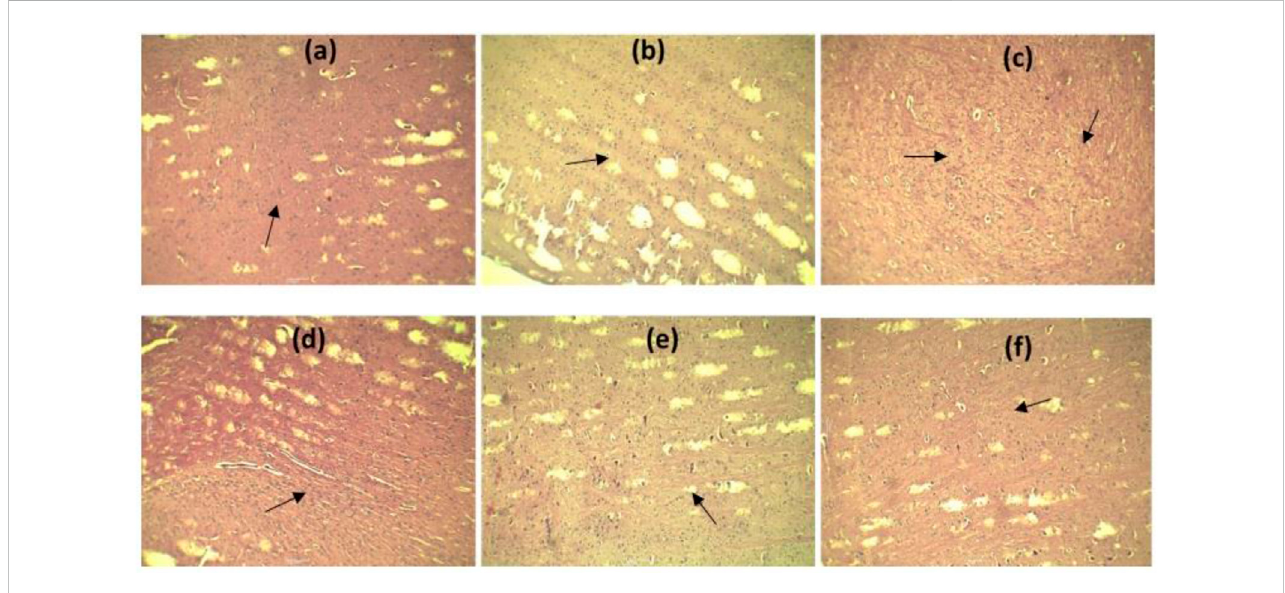
FIGURE 7 Effect of RES on the cortical regions of brain histology: (A) Negative control; (B) positive control; (C) standard; (D) RES 50 mg/kg; (E) RES 75 mg/kg; (F) RES 50 mg/kg + vitamin E.